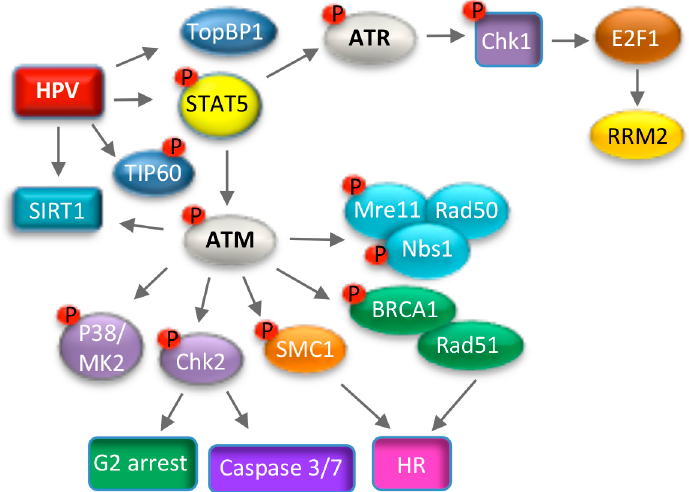
Figure 5. Modulation of the ATM and ATR DNA damage response pathways to promote productive viral replication. HPV-induced activation of ATM requires the STAT5 immune regulator, as well as TIP60, but not the MRN complex. Downstream effectors of ATM required for productive viral replication include the MRN complex, p38/MK2, Chk2, as well as factors involved in homologous recombination repair (Rad51, BRCA1, SMC1). HPV may utilize ATM activity to promote G2 arrest upon differentiation through activities of Chk2, as well as to direct repair to HR on viral genomes through epigenetic modifications and the recruitment of homologous recombination (HR) repair factors. ATR activation in HPV positive cells likely occurs through E7-induced replication stress and requires a STAT5-directed increase in TOPBP1. ATR/Chk1 activation leads to increased levels of E2F1, which drives expression of RRM2, resulting in increased dNTP pools to facilitate productive viral replication.